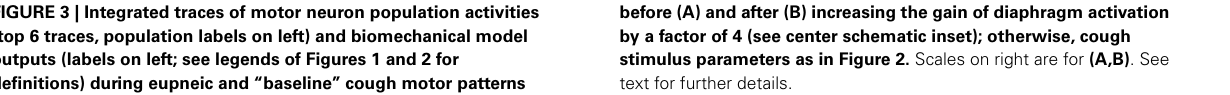
(B) caused peak expiratory tracheal flow to decrease relative to